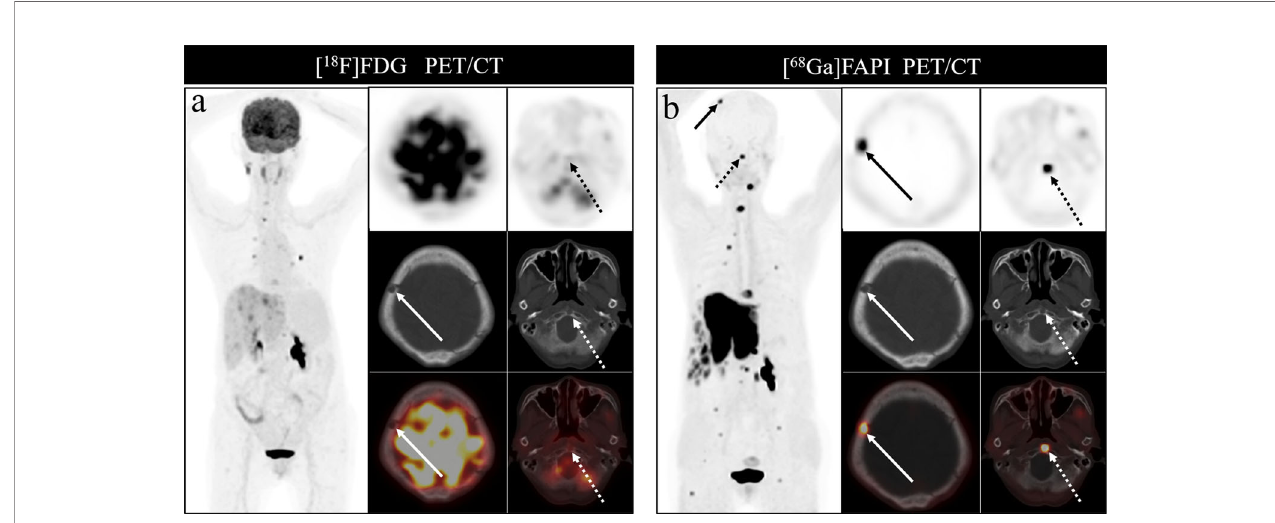
FIGURE 7 | A 76-year-old woman underwent [ 18 F]FDG and [ 68 Ga]Ga-DOTA-FAPI-04 PET/CT (A, B) to assess possible recurrence of thyroid cancer. The MIP image (A, B) of [ 18 F]FDG and [ 68 Ga]Ga-DOTA-FAPI-04 PET/CT demonstrated multiple tracer activities bone and liver lesions. On the selected axial images, [ 18 F]FDG PET/CT (A) showed limited [ 18 F]FDG uptakes in the parietal bone (arrows) and clivus (dashed arrows), while [ 68 Ga]Ga-DOTA-FAPI-04 PET/CT (B) showed intense [ 68 Ga]Ga-DOTA-FAPI-04 uptakes in the parietal bone (arrows) and clivus (dashed arrows). In addition, the expression of [ 68 Ga]Ga-DOTA-FAPI-04 in liver metastasis was signi fi cantly higher than that of [ 18